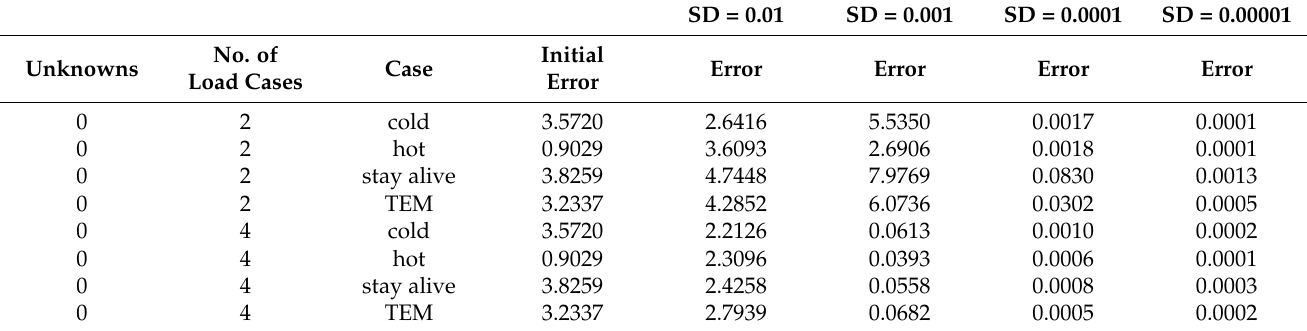
Table 14. Errors obtained for predicted temperatures for transient 16 nodes